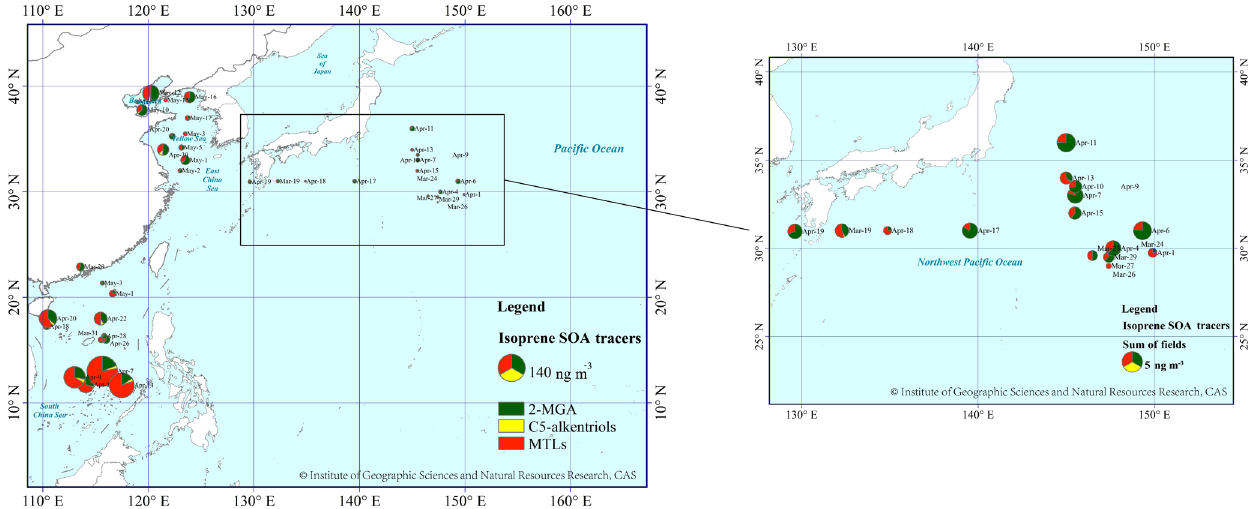
Figure 3. The spatial distribution of SOA I tracer compounds over three marine regions: YBS and NWPO in 2014 and SCS in 2017. The area of the pie indicates the concentration of total SOA I tracers. The base map was sourced from the Resource and Environment Data Cloud Platform (http://www.resdc.cn/DOI/doi.aspx?DOIid=56), © Institute of Geographic Sciences and Natural Resources Research, Chi- nese Academy of Sciences (CAS). (Please note that the above figure contains disputed